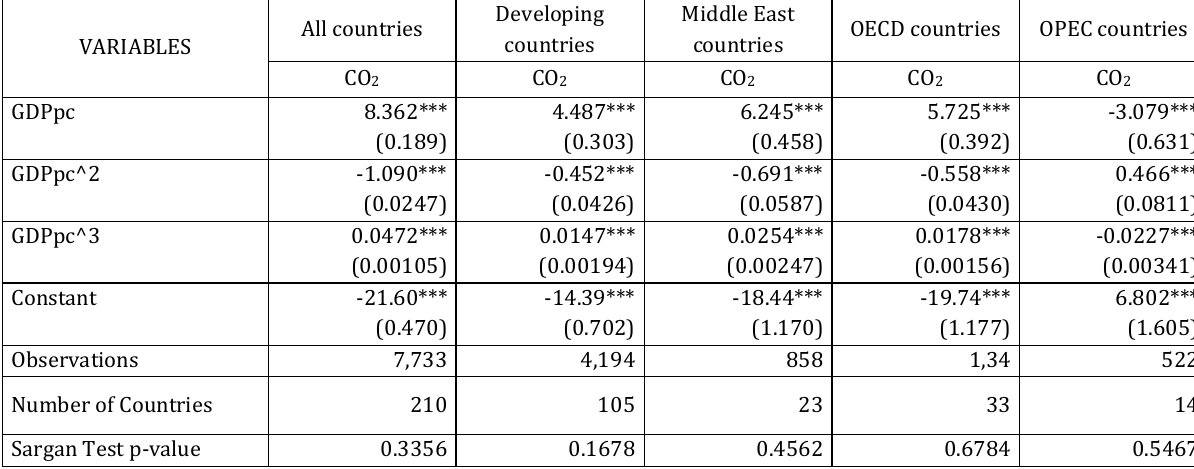
Table 4. GMM regression results